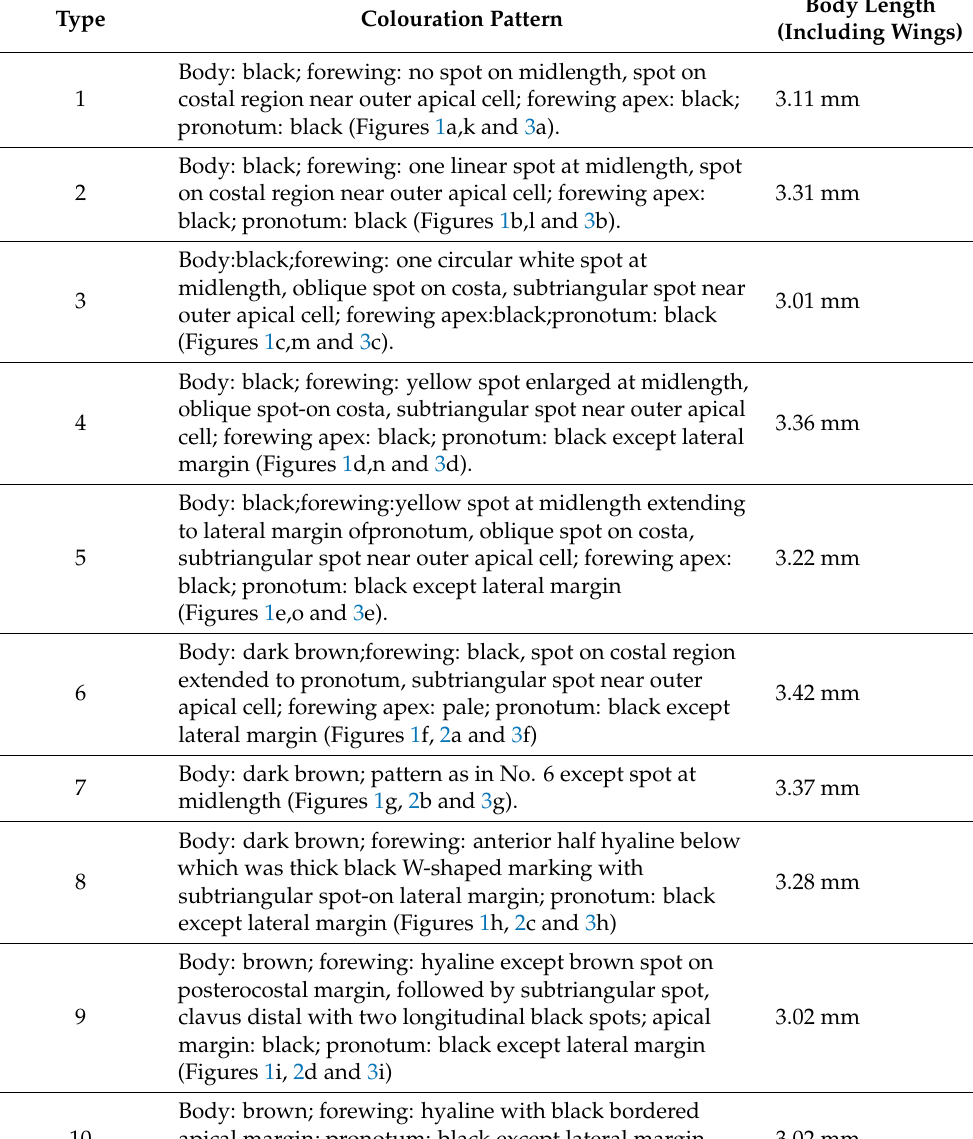
Body Length (Including Wings)